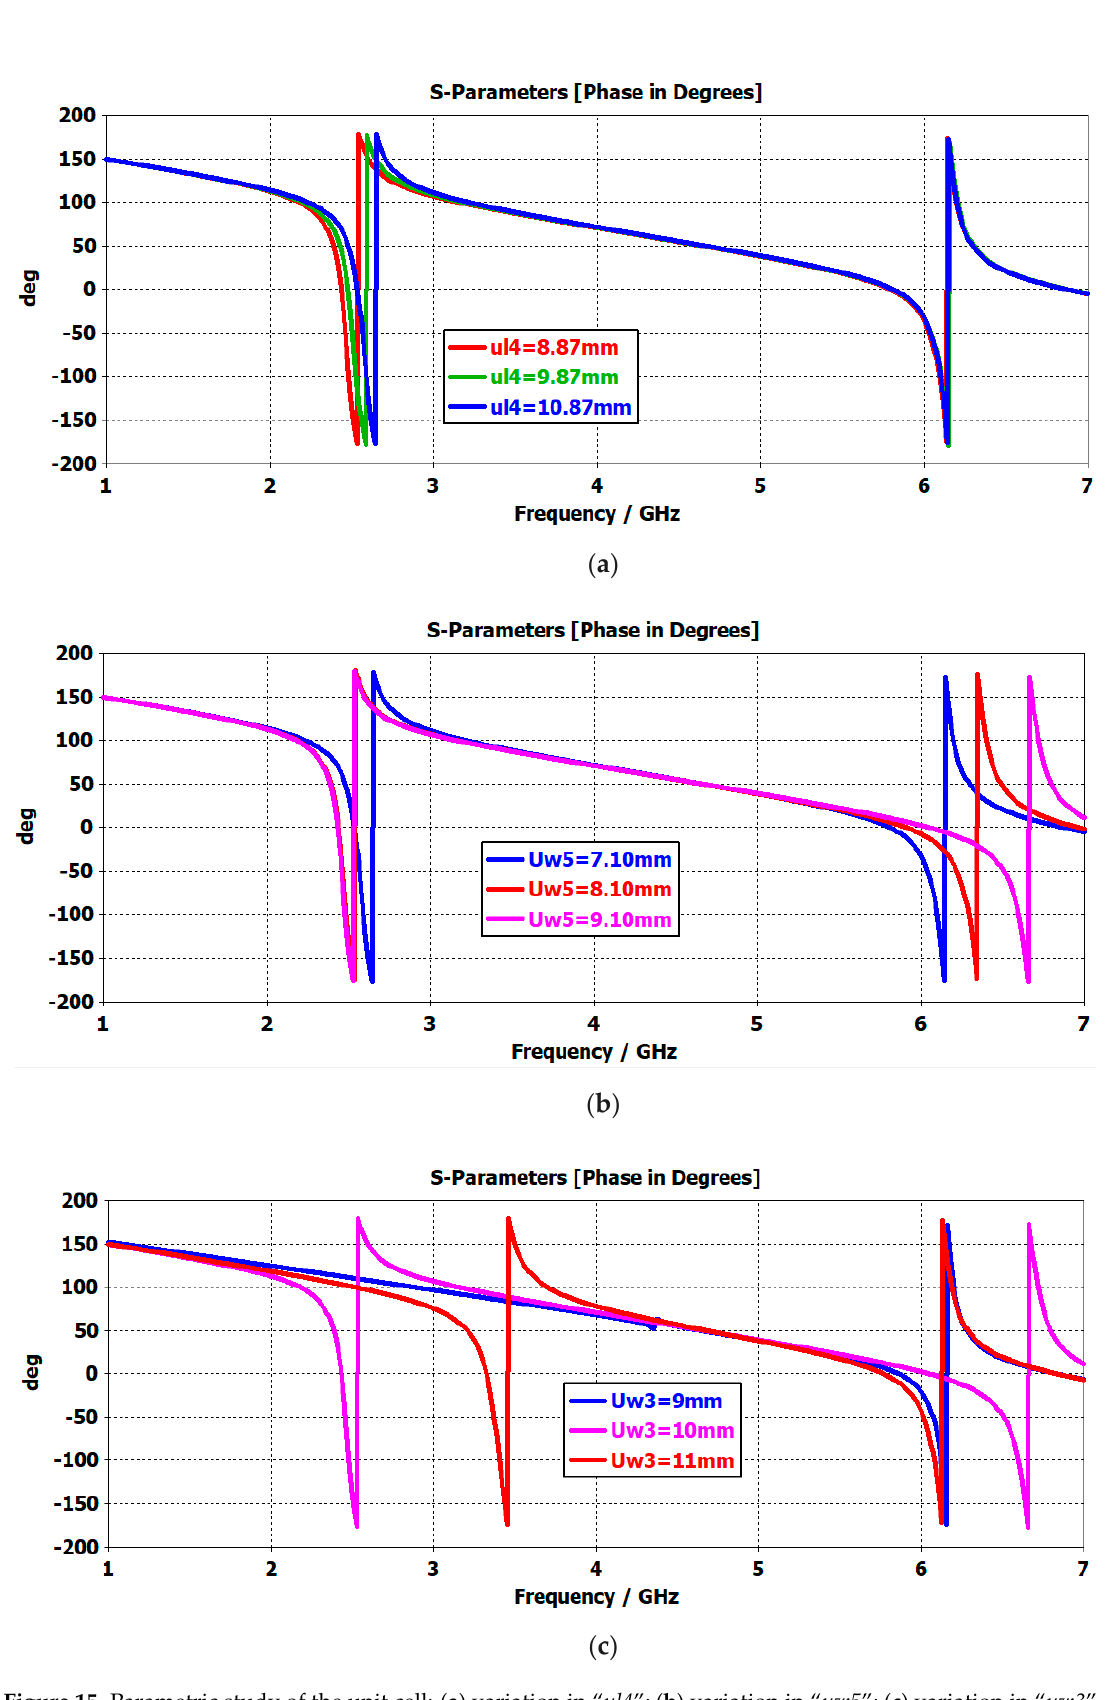
Figure 15. Parametric study of the unit cell: ( a ) variation in “ul4” ; ( b ) variation in “uw5” ; ( c ) variation in “uw3”.